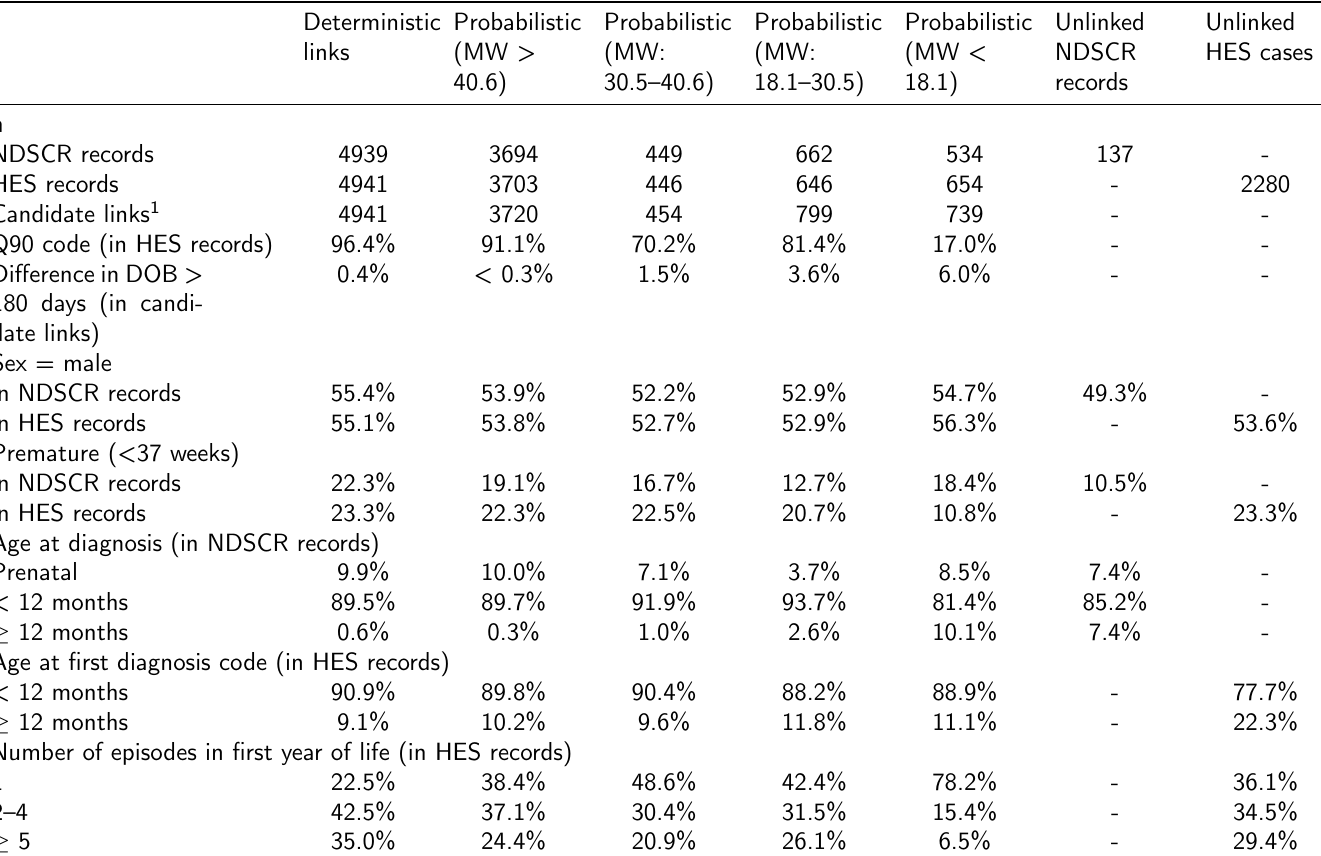
Table 1: Characteristics of linked and unlinked